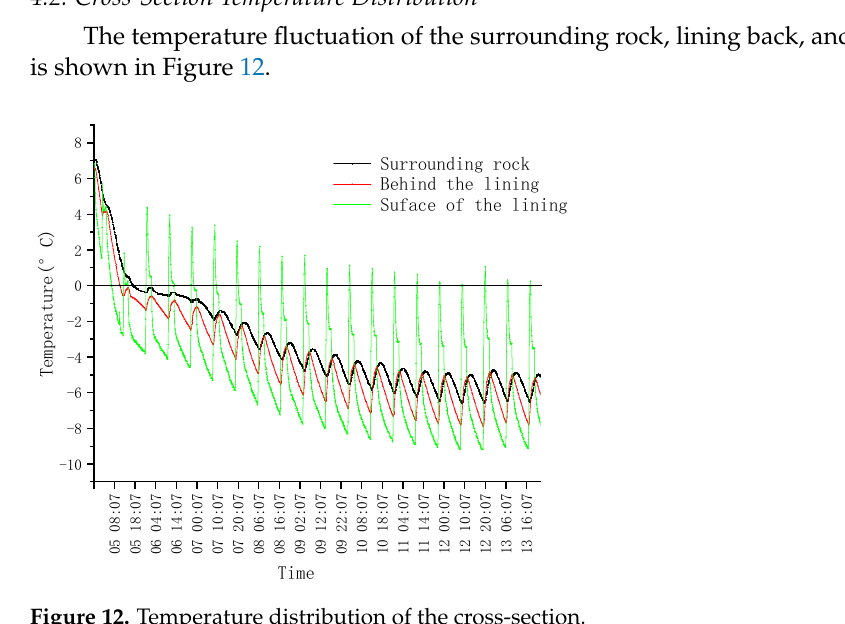
Figure 12. Temperature distribution of the cross-section. The fluctuation amplitude of the surface temperature of the model is significantly larger than that behind the model, and the fluctuation amplitude of the temperature behind the model is significantly larger than that in the surrounding rock. The fluctuation amplitude of each section is shown in Figure 13. The amplitude of fluctuation decreases from the surface to the inside of the surrounding rock, which is consistent with the law of temperature fluctuation measured by the research group in the Wushaoling tunnel groups and Hongfu tunnel, indicating that the model test simulates the characteristics of the thermal conduction of the tunnel lining and surrounding rock.